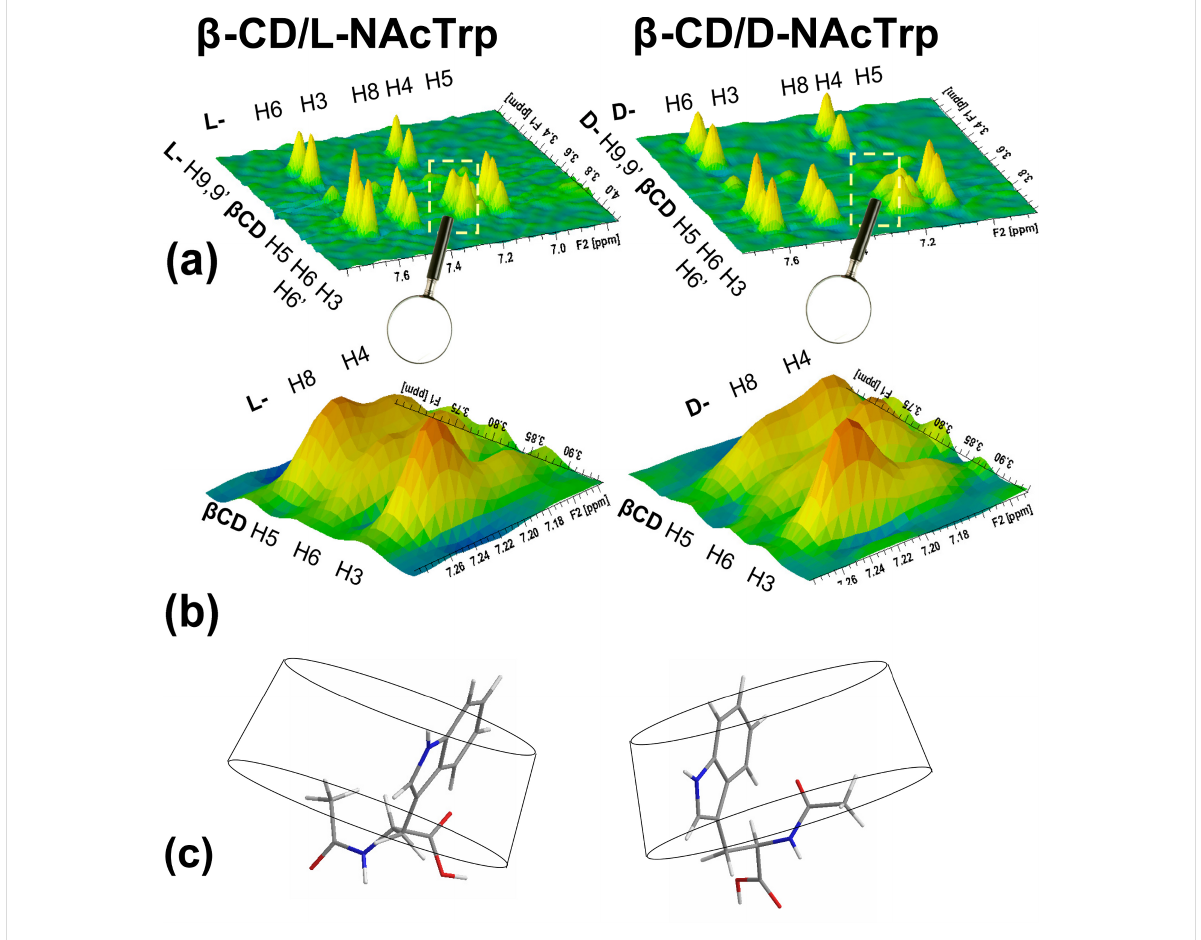
Figure 1: 3D maps of the observed dipolar, through-space host–guest interactions depicted so as to (a) reflect ≈ equally strong cross-peaks in each L- and D-NAcTrp enantiomer for intramolecular correlations, namely guest H9,9’ with guest H6 and H8; (b) the few differences observed in the inter- molecular interactions have been magnified and reflect somewhat different binding modes of the two enantiomers revealed by intermolecular interac- tions of guest protons H8 and H4 only; (c) schematic representation of the respective solution models for each 1:1 complex.